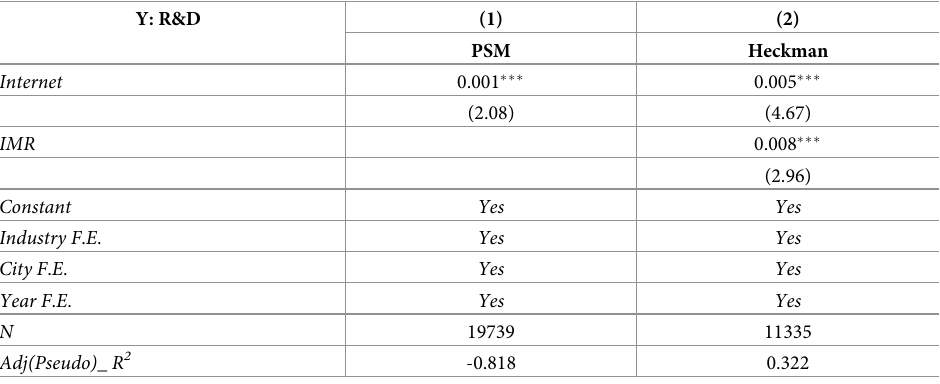
Table 4. PSM and Heckman